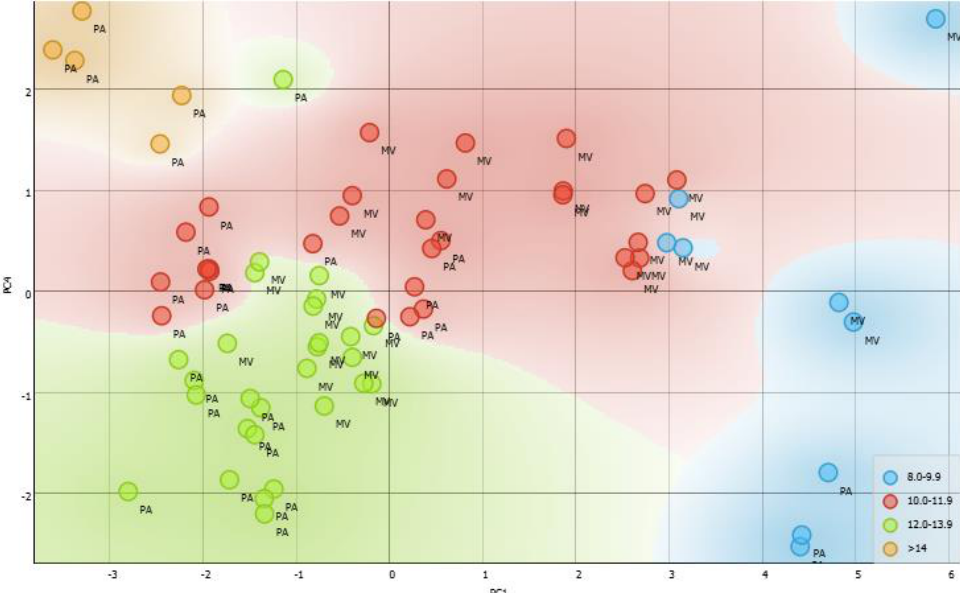
Figure 6. Principal components analysis showing correlation of groups of PC4 versus PC1 using the obtained data from the analysis of phenolic and total flavonoid content, RA content, EC 50 , SPF, the incidence of solar radiation, and level of precipitation.